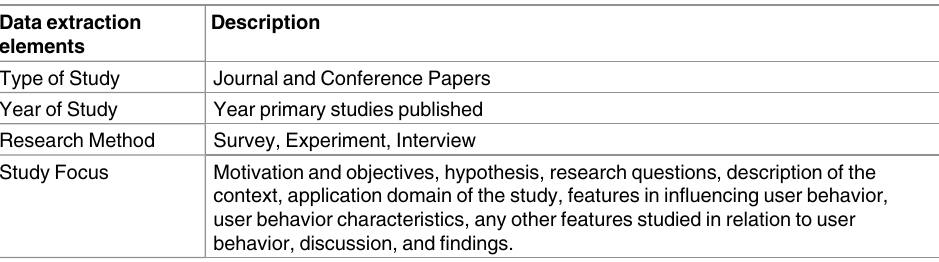
Table 5. Content assessment criteria.